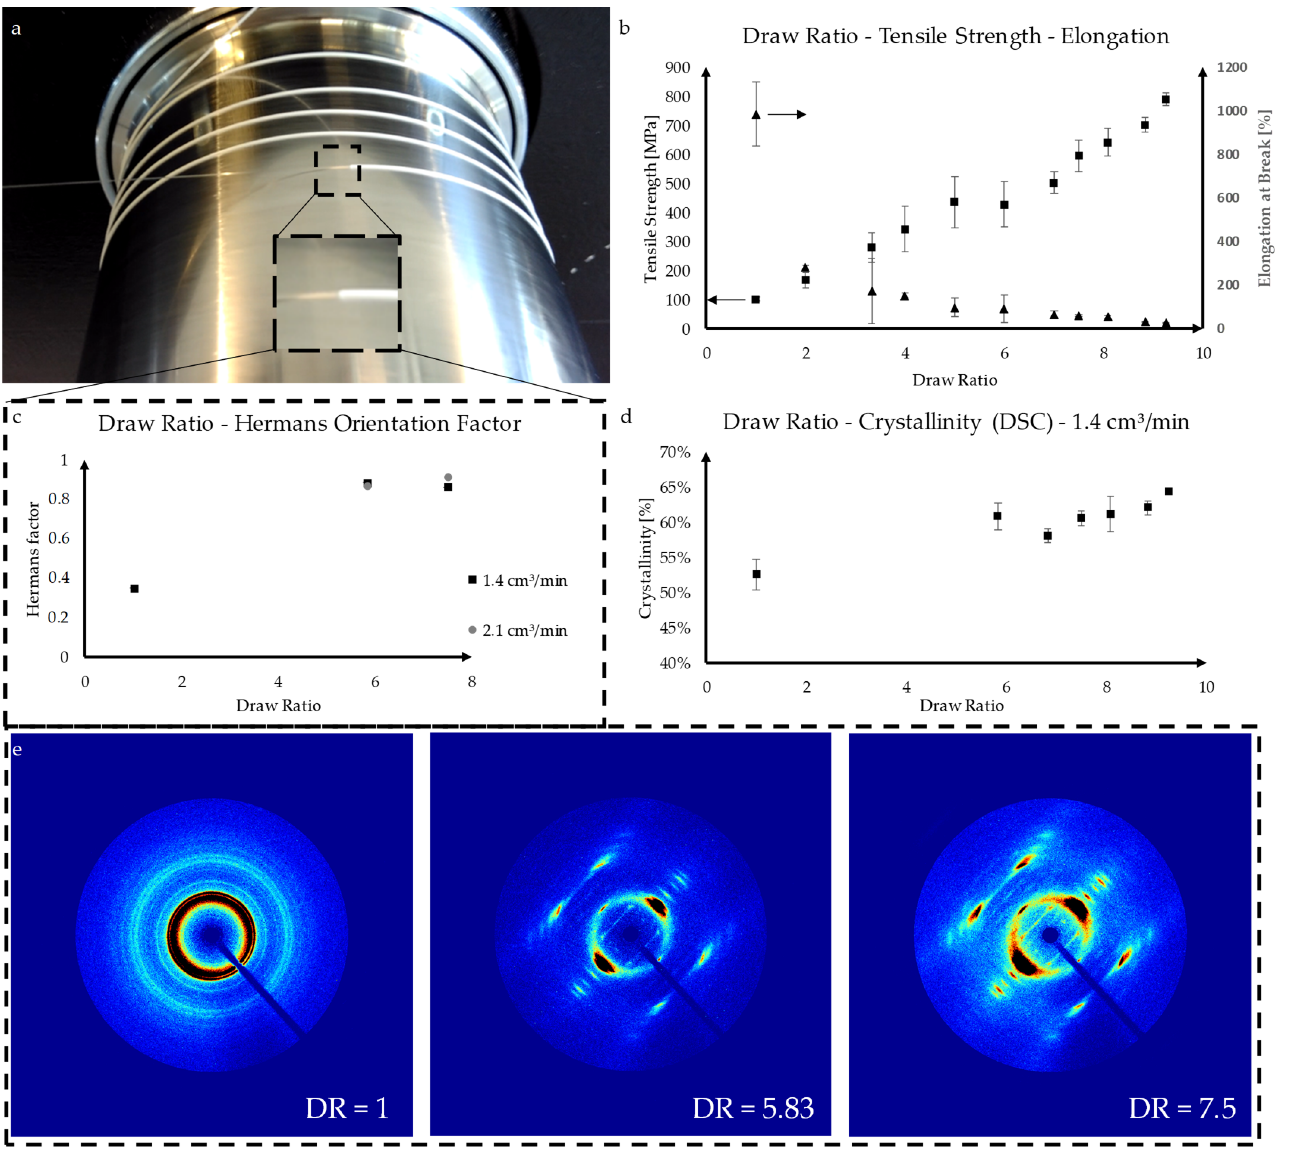
Figure 3. Influence of draw ratio (DR) on mechanical properties, orientation and crystallinity. ( a ) Locally stable and pronounced necking point during drawing between DR5.58 and DR9.25, ( b ) Effect of draw ratio on tensile strength and elongation at break, ( c ) Hermans orientation factor for a throughput of 1.4 cm 3 /min and 2.1 cm 3 /min, ( d ) Effect of draw ratio on crystallinity, ( e ) WAXD images for DR1, DR5.83 and DR7.5.